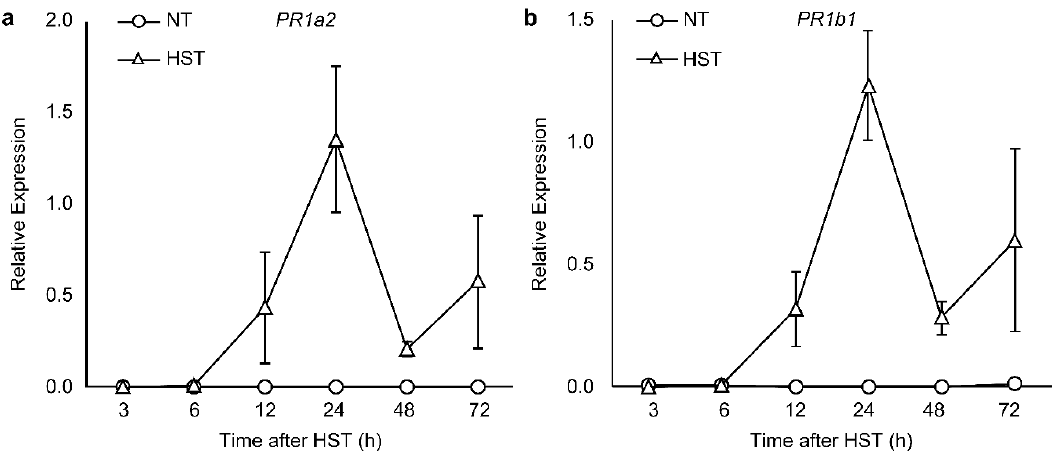
Figure 2. Changes in ( a ) PR1a2 , and ( b ) PR1b1 expression levels in the tomato cultivar Natsunokoma. Gene expression levels in the first leaf at 3, 6, 12, 24, 48, or 72 h after HST (45 °C, 2 min) were quantified by qPCR and normalized to GAPDH expression. Vertical bars indicate the standard error of the mean ( n = 4).